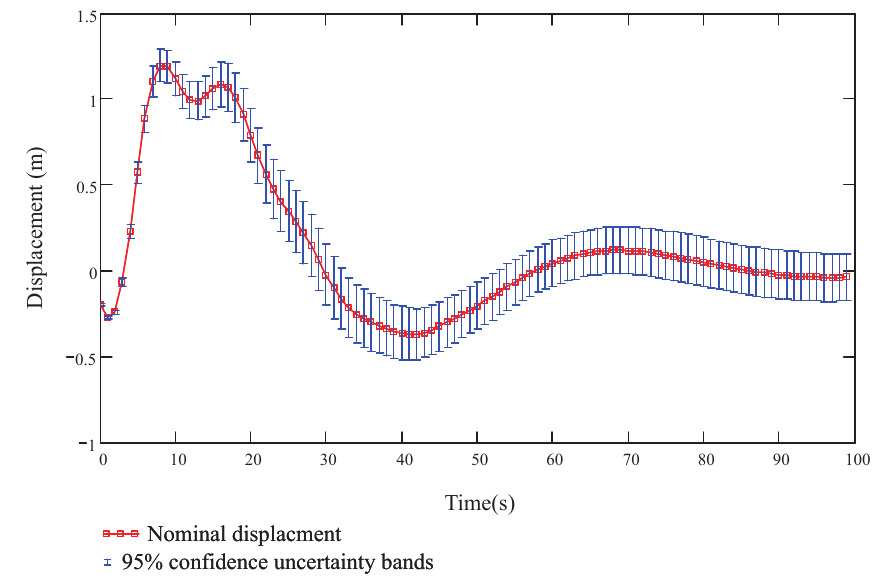
Fig. 9. 95% con fi dence displacement uncertainty